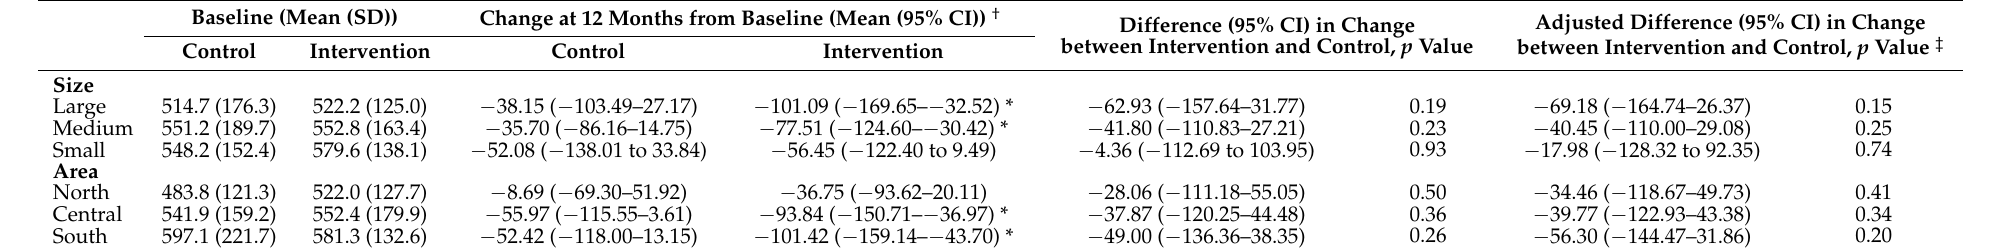
Table 3. Subgroup analysis of sodium content by laboratory test (mg/100